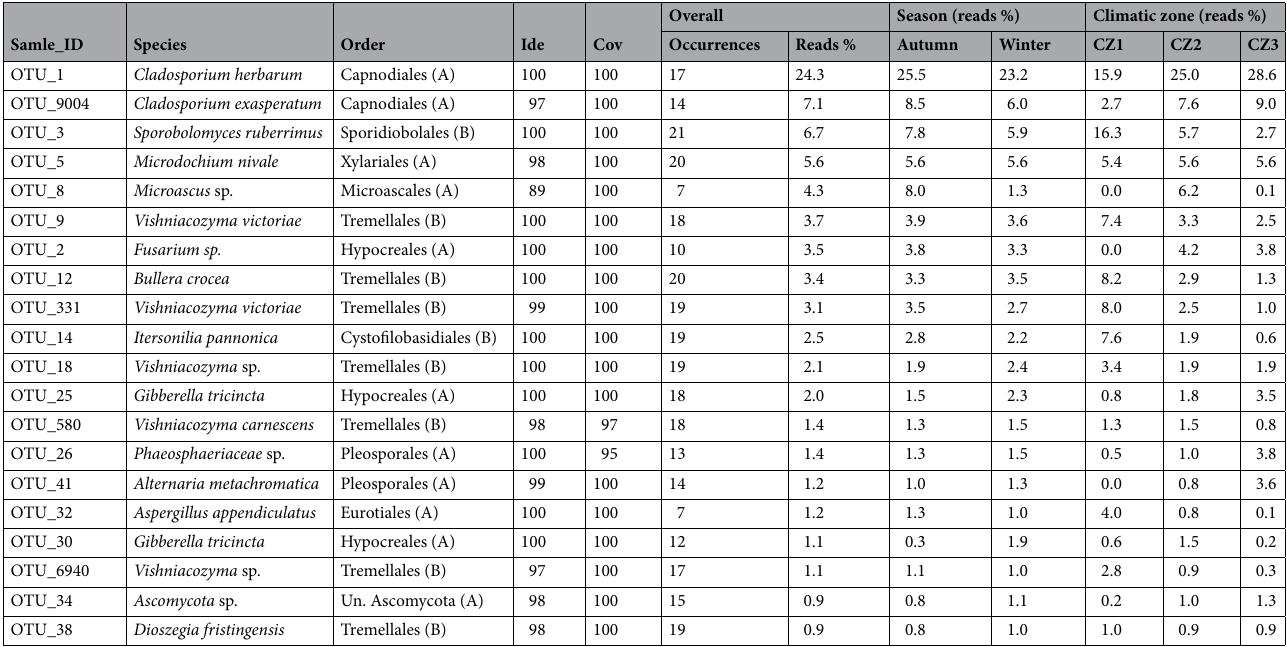
Table 3. Taxonomic affinity and occurrences of the 20 most abundant operational taxonomic units (OTUs) detected industrial grain mill air during different seasons (autumn and winter) and in three different climatic zones. For overall communities both occurrences and % total reads are shown, but for season and climatic zone only % total reads data is provided here. Ide % identification against reference sequence from UNITE database, Cov % sequence